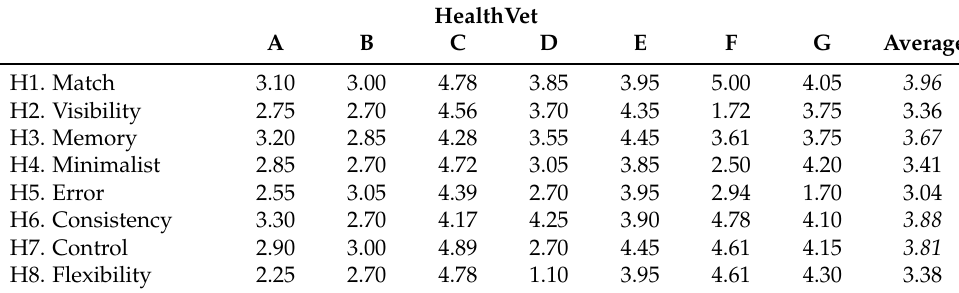
Table 5. Average usability assessments in HealthVet.